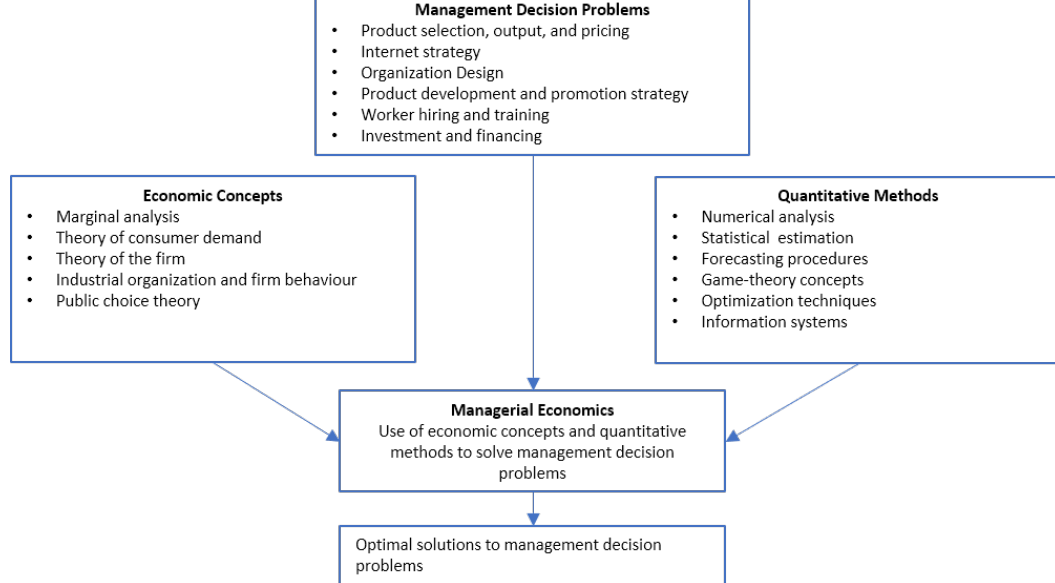
Figure 1. Concepts, problems, and methods of ME/BE. Source: based on Hirschey and Bentzen